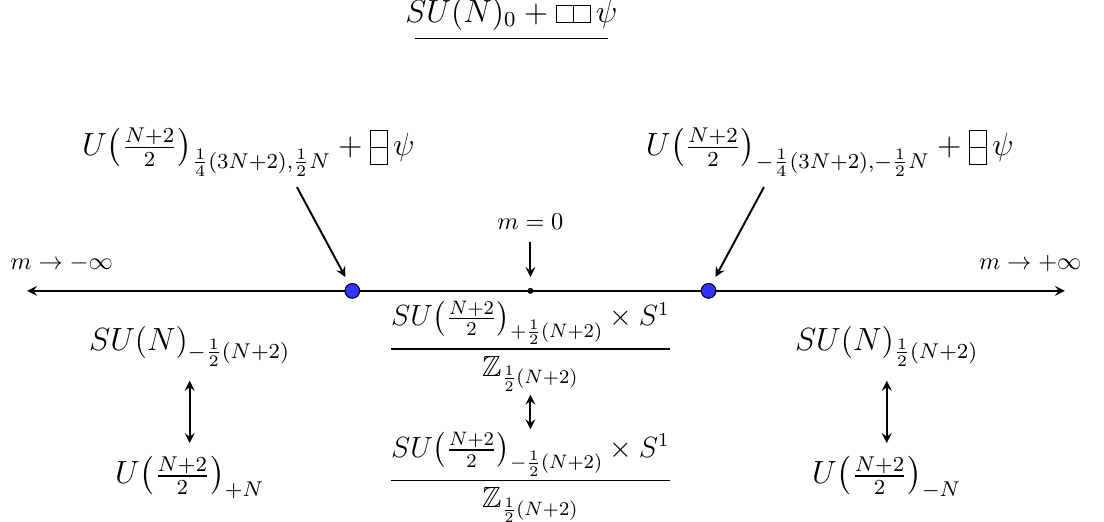
Figure 5 . Phase diagram of SU( N ) gauge theory with a symmetric fermion for k = 0. The circle S 1 represents the corresponding sigma model. Each phase transition has a dual gauge theory description, which appears with an arrow pointing to the phase transition. The mass deformations are related by m = (cid:0) m ^ and m = (cid:0) m ~